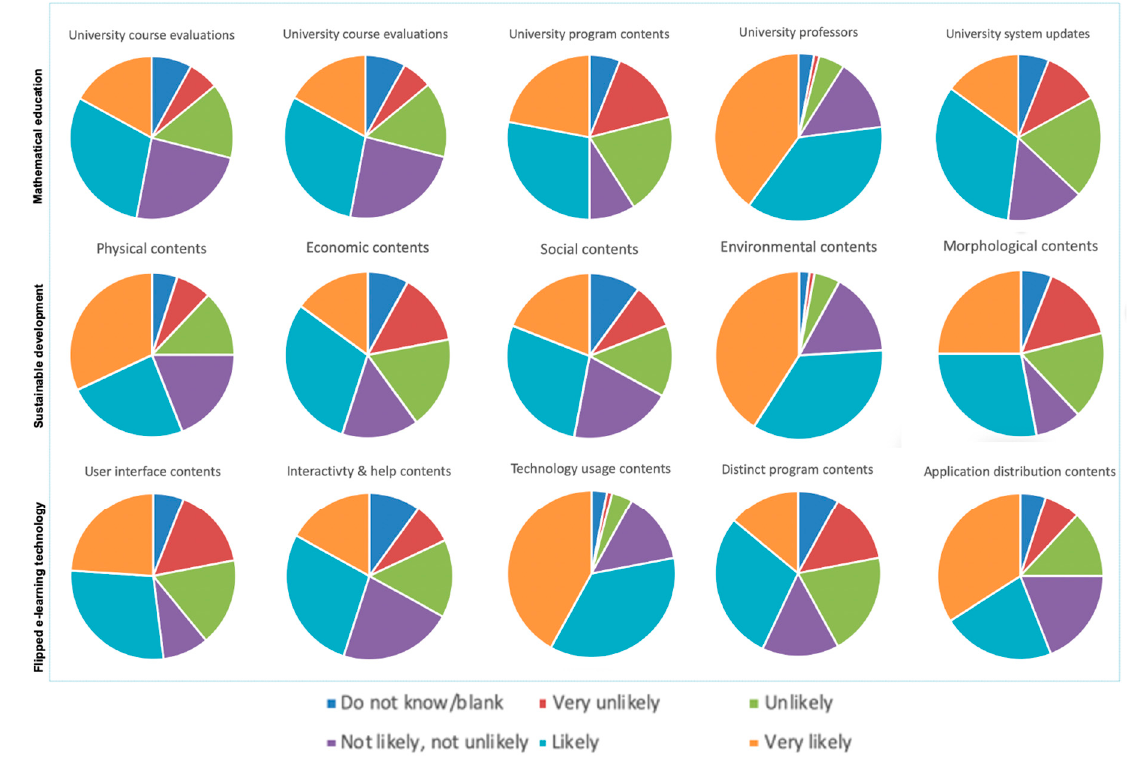
Figure 6. Likert scale survey examination for fifteen sub-criteria that were classified into three criteria.